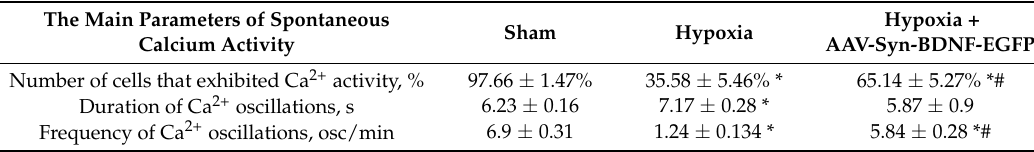
Table 3. The main parameters of spontaneous calcium activity in primary hippocampal cultures on day 7 after hypoxia modelling (28